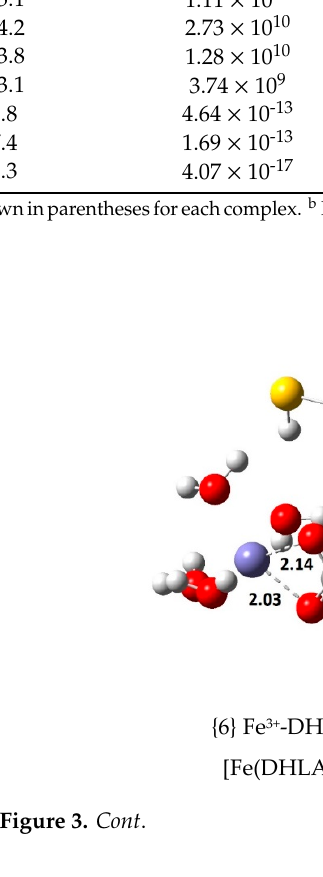
◦ , in kcal / mol) and formation constant ( K f , log K f ) for f